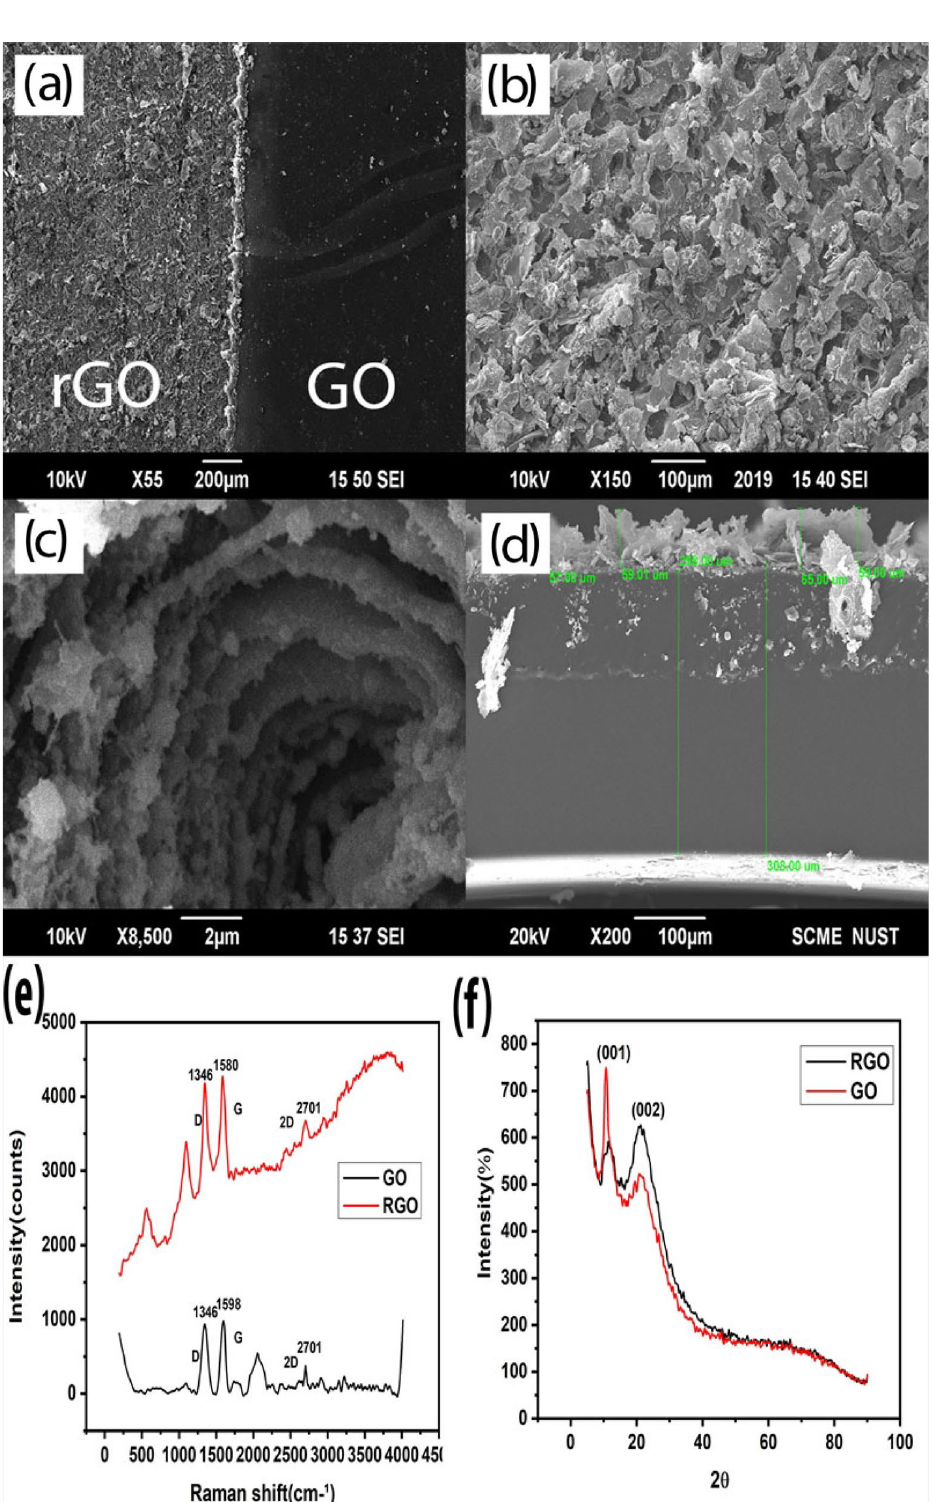
Figure 3. Characterization of GO and laser scribed rGO. Morphology comparison of ( a ) SEM images depicting the difference between the surface structure of GO and rGO. ( b ) The porous structure of rGO after reduction. ( c ) rGO flakes sharing their surface area with each other helps in sensing strain. ( d ) The thickness of rGO increases with respect to GO after reduction. ( e ) RAMAN spectroscopy of GO and rGO depicts that the reduction has taken place. ( f ) A sharp peak of XRD Diffraction at 10.75° confirms GO and after the reduction, another peak at 22.1° confirms rGO